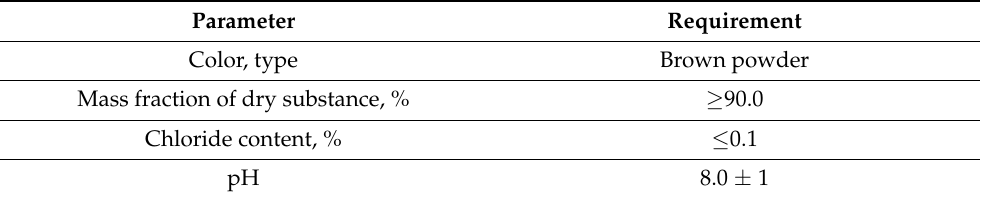
Figure 2. Structural formula of sulfonaphthalene-formaldehyde plasticizer. Table 6. Superplasticizer characteristics.